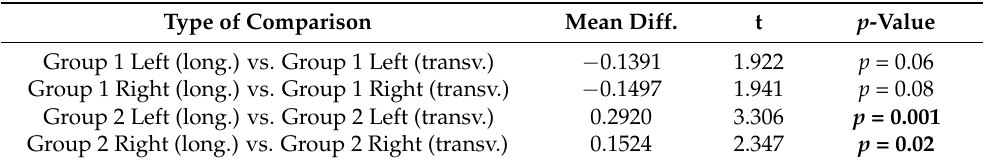
Table 5. Ultrasound measurements comparison between th edifferent axes in the US examination of the TLF thickness within each group. Bold: statistically significant differences. Type of Comparison Mean Diff. t p -Value Group 1 Left (long.) vs. Group 1 Left (transv.) − 0.1391 Group 1 Right (long.) vs. Group 1 Right (transv.) Group 2 Left (long.) vs. Group 2 Left (transv.) Group 2 Right (long.) vs. Group 2 Right (transv.)